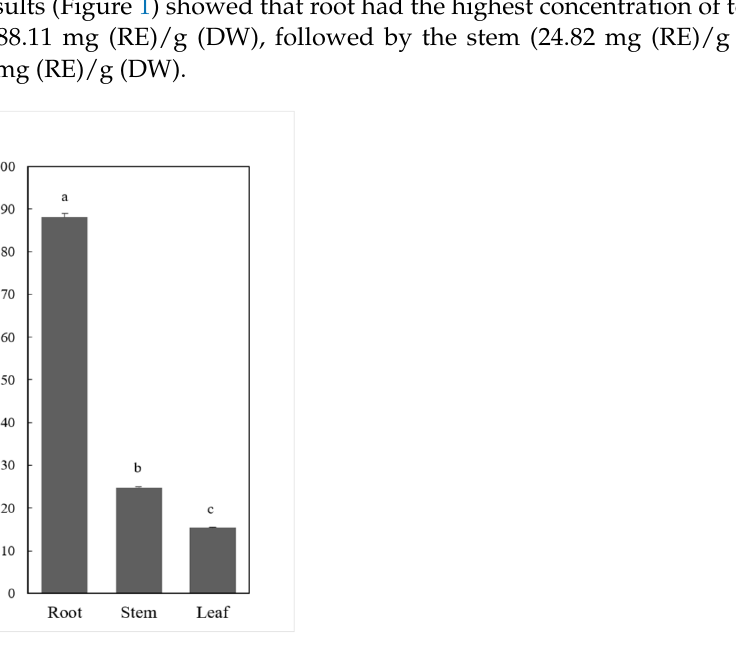
Figure 1. Total flavonoids content for C. rotundifolia organs. Flavonoids content was expressed as the rutin equivalent mg/g of the dry weight. The data were expressed as mean ± SD for three replicates. The letters indicate a significant difference at p <